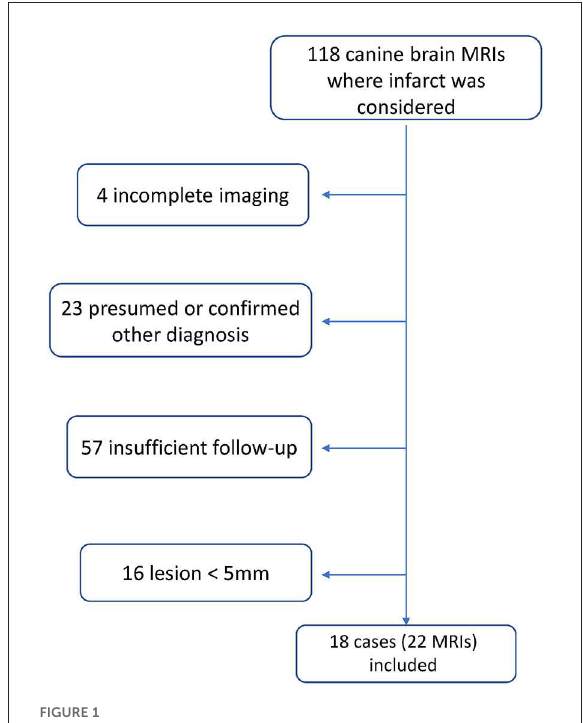
FIGURE1 Schematic of record search and case selection